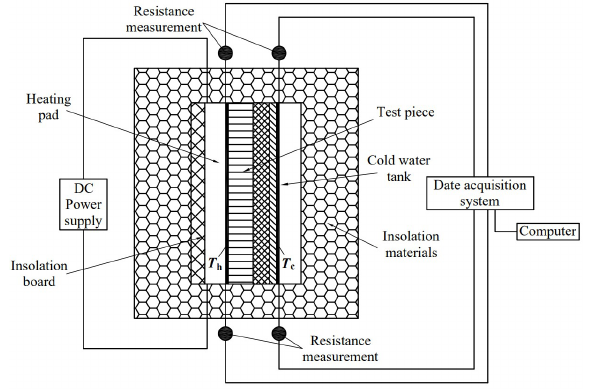
Fig. 3. Schematic view of the experimental system.